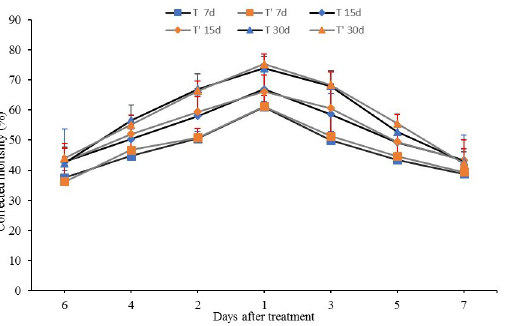
Fig 2. Effects of different rates of fluopyram on the functional diversity of the soil microbial community. The dashed line represents the average percentage of control. “ � ” represents significant differences between two-time treatments and control at each time as measured by Tukey’s test (P <